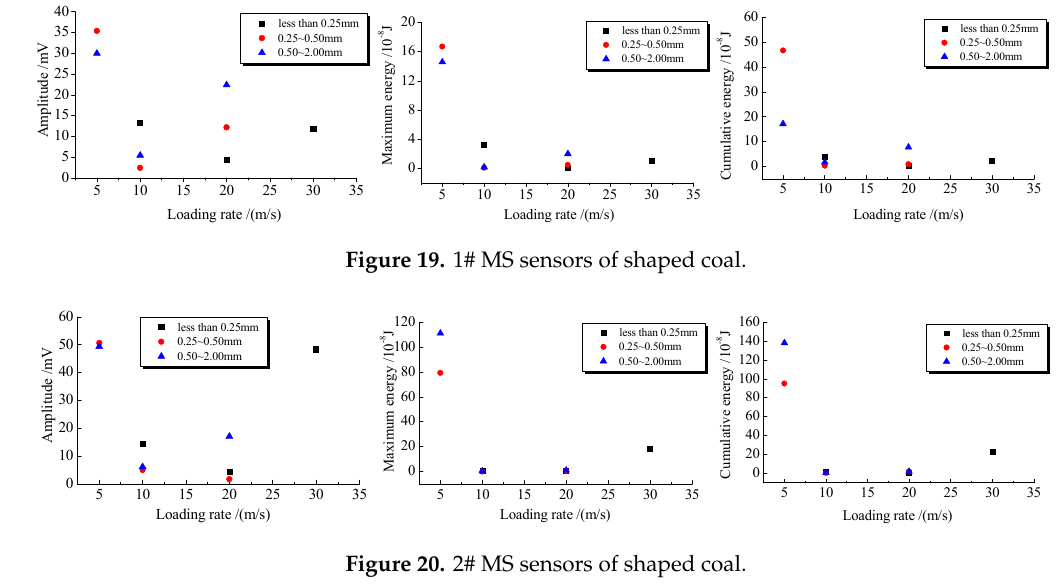
Figure 20. 2# MS sensors of shaped coal.